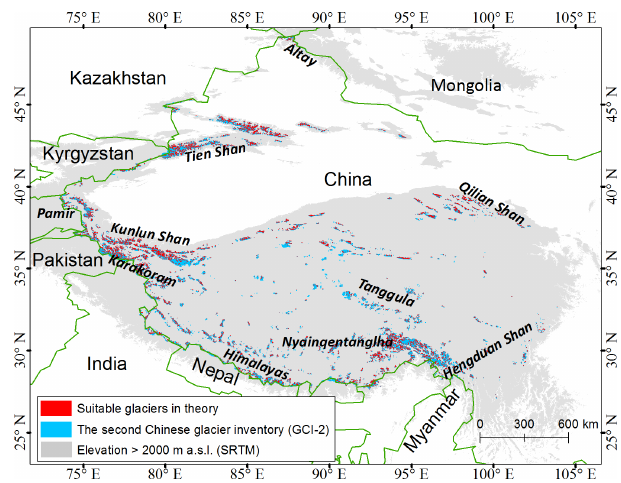
Figure 12. Spatial distribution of suitable glaciers: in theory those glaciers with an area of ≤ 1 . 6km 2 (approximate area of Urumqi Glacier No. 1) and a surface slope greater than 23.4 ◦ (mean slope of Urumqi Glacier No. 1) have huge potential to be monitored using the TLS. National boundary is from the